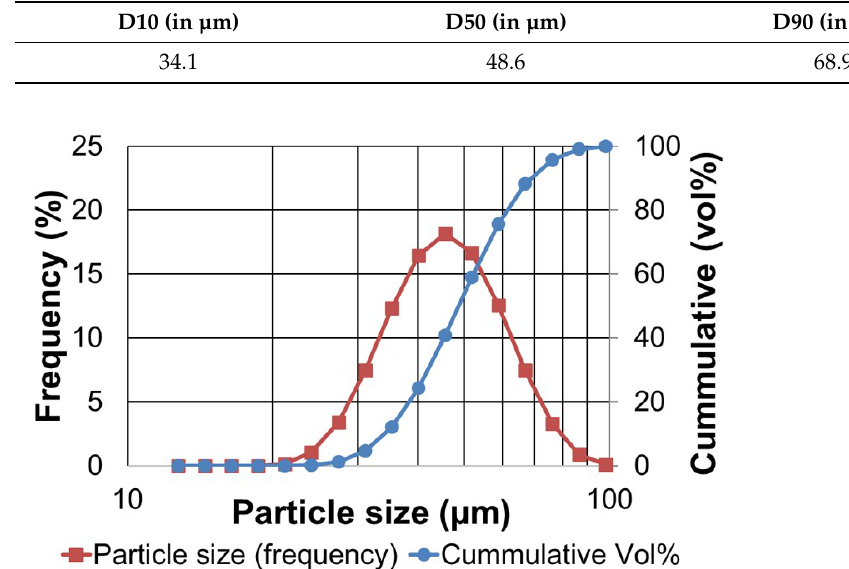
Table 1. Powder size distribution for Scalmalloy ® powder used (averaged over five measurements).